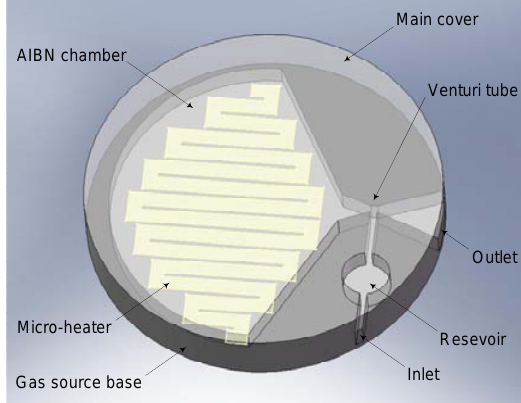
Figure 2. The conceptual schematic of a gathering tool (the AIBN matrix on the micro-heater is omitted for